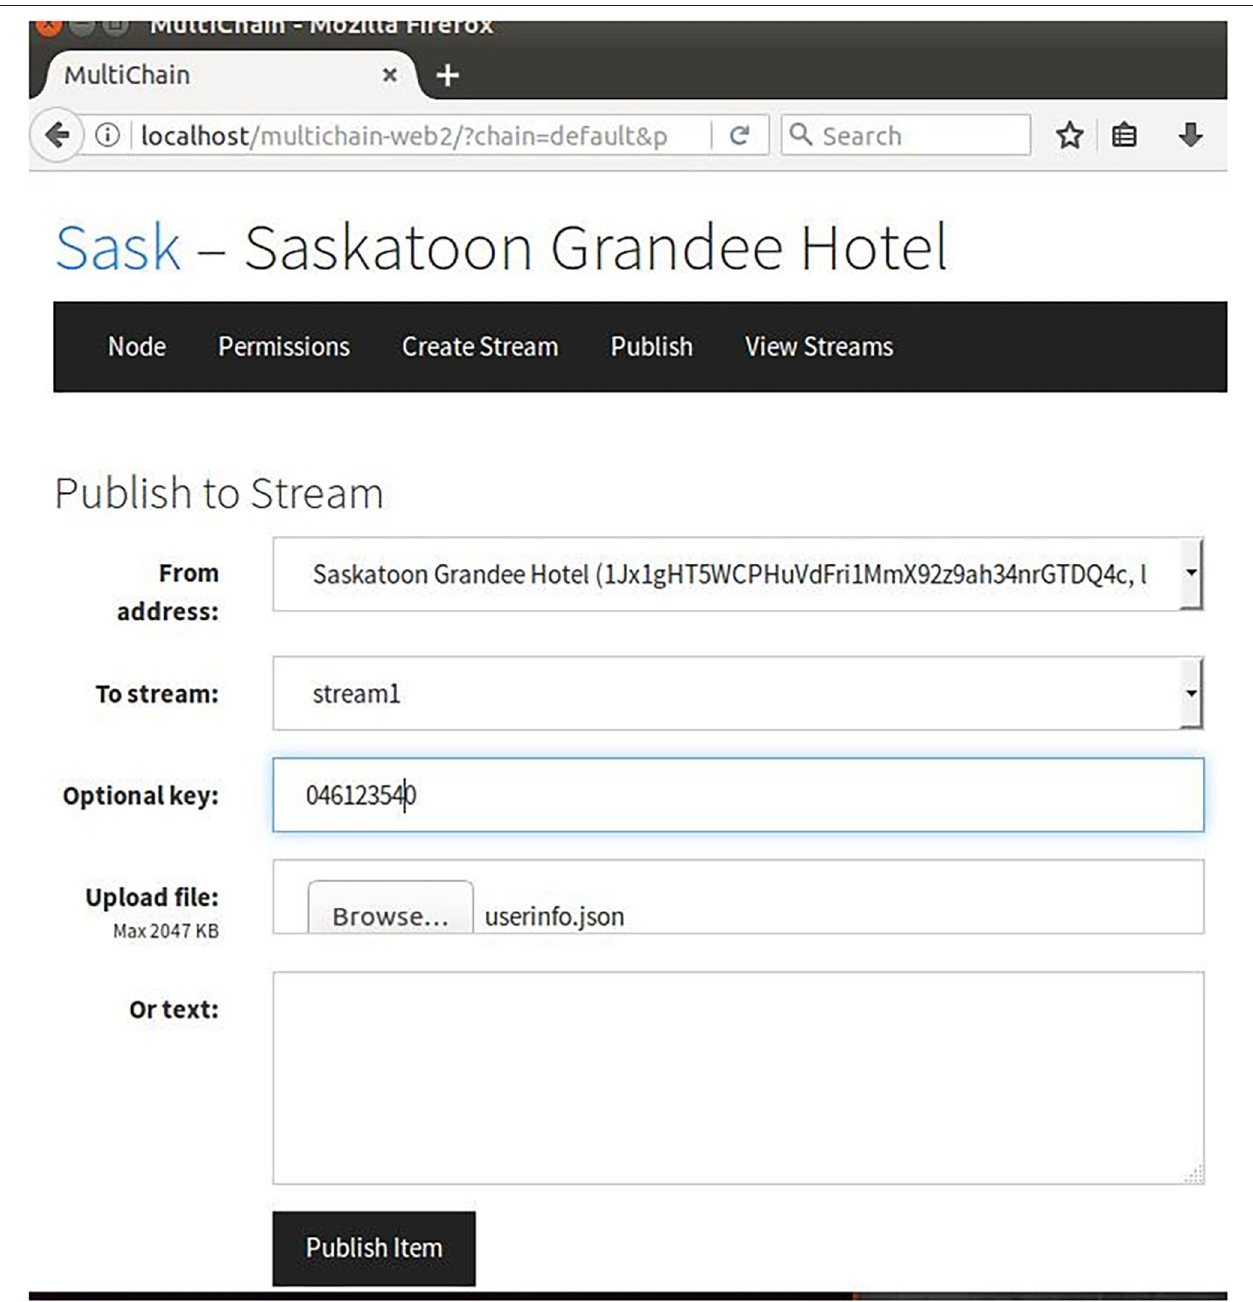
FIGURE 5 | Publishing stream of